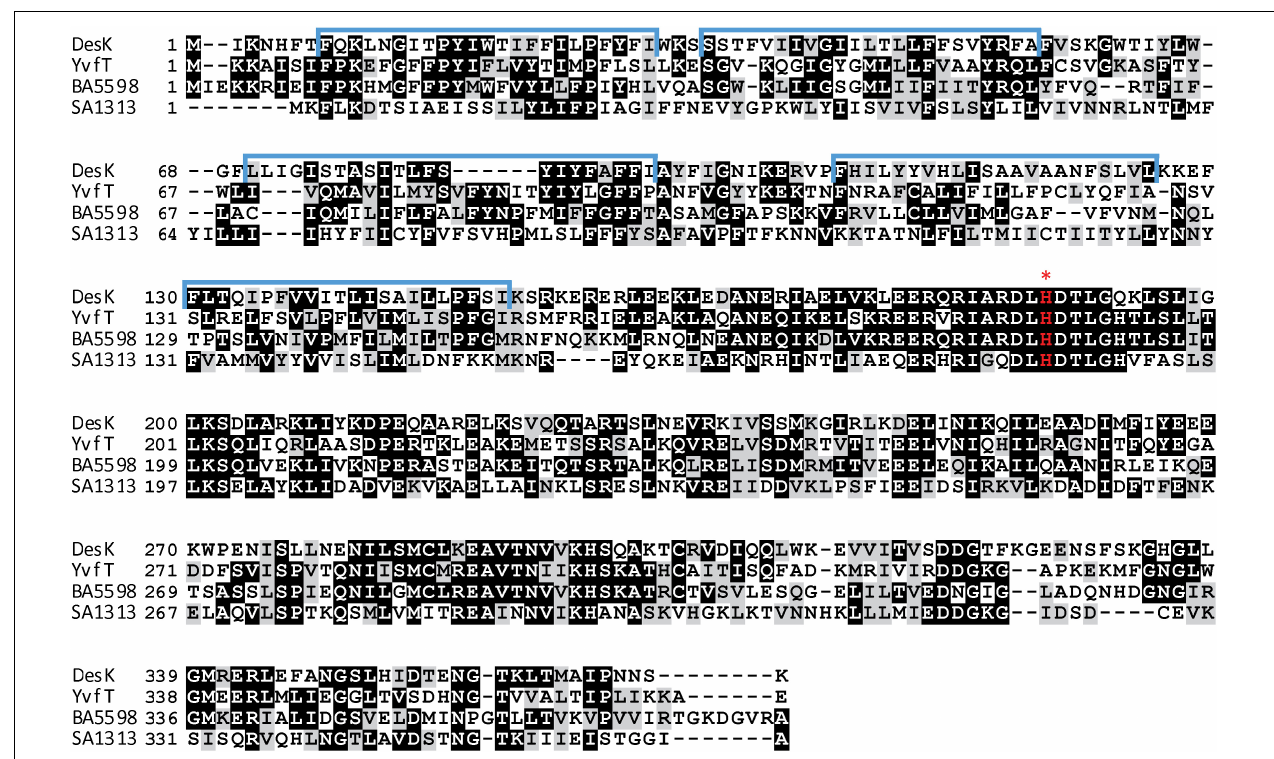
FIGURE 1 | Amino acid sequence alignment of HKs, DesK, YvfT, BA5598 and SA1313. Identical amino acids are shown highlighted in black and similar ones are highlighted in gray. TMS are marked above the DesK sequence in blue (Cybulski et al., 2010). The red asterisk indicates the phosphorylatable